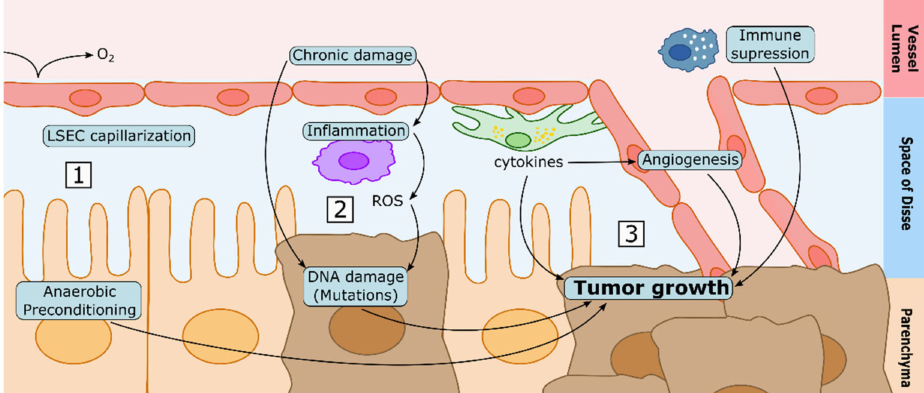
Figure 4. Proposed mechanisms linking CLD and HCC development. ( 1 ) The capillarization of LSECs may lead to less oxygen diffusing to the space of Disse. Therefore, hepatocytes may be preconditioned to anaerobic metabolism in CLD, which may represent an advantage to tumoral cells in hypoxic conditions. ( 2 ) Chronic damage and the associated chronic inflammation are known causes of DNA damage, which may lead to cellular dedifferentiation and tumorigenesis. ( 3 ) Cytokines released by the different hepatic cell types in conditions of chronic liver damage may induce tumour growth directly, enhancing neovascularization, or by suppressing the immune